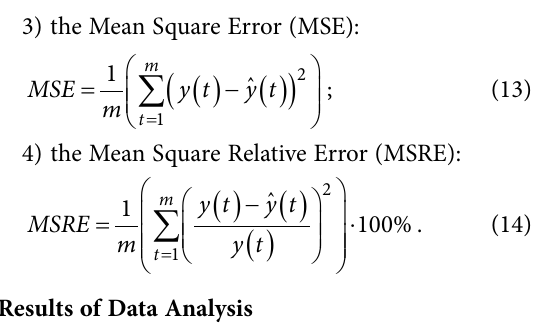
Fig. 4. 5-min average traffic flow, ACF and PACF at Site